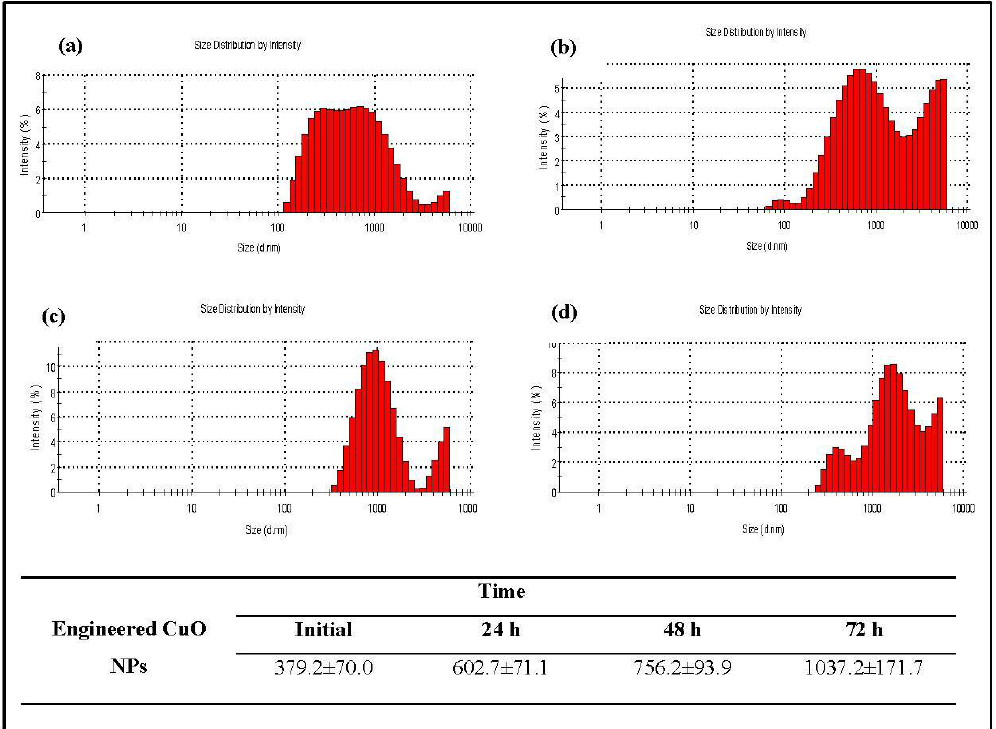
Figure 8. Size and size distribution of engineered copper nanoparticles ( a ) initial; ( b ) 24 h; ( c ) 48 h and ( d ) 72 h.